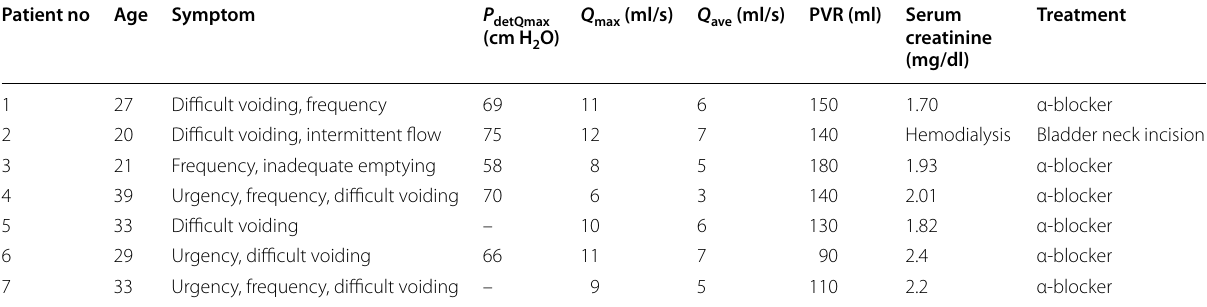
P detQmax : detrusor pressure at maximum flow rate; Q max : maximum flow rate; Q ave : average flow rate; PVR: post-void residual urine